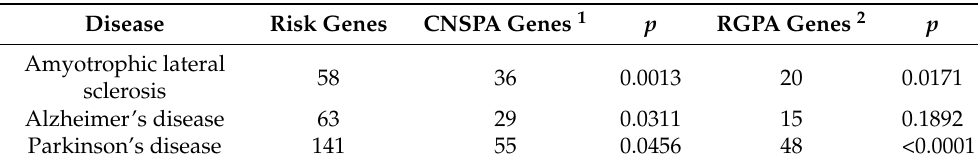
Table 1. Associations between risk genes of neurodegenerative diseases and differentially expressed genes induced by CNS or RG promoter activation.